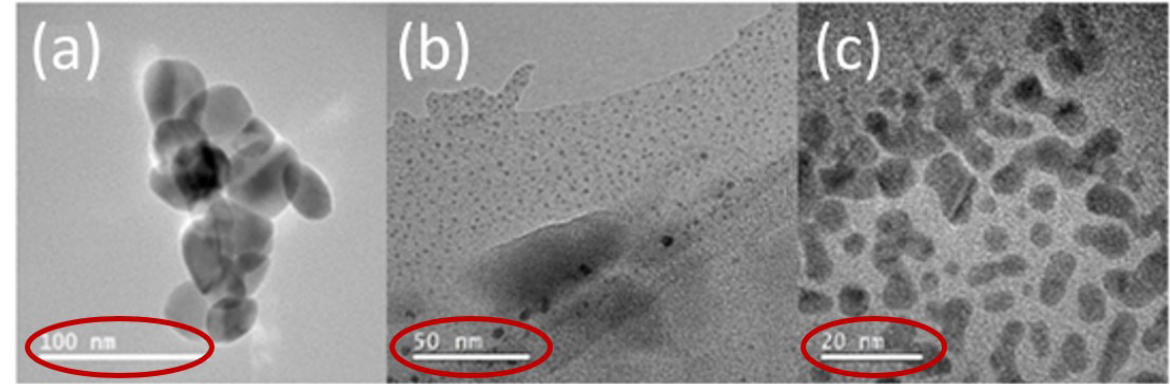
Figure 3. TEM images for (a) CuO NPs, (b) the Cu